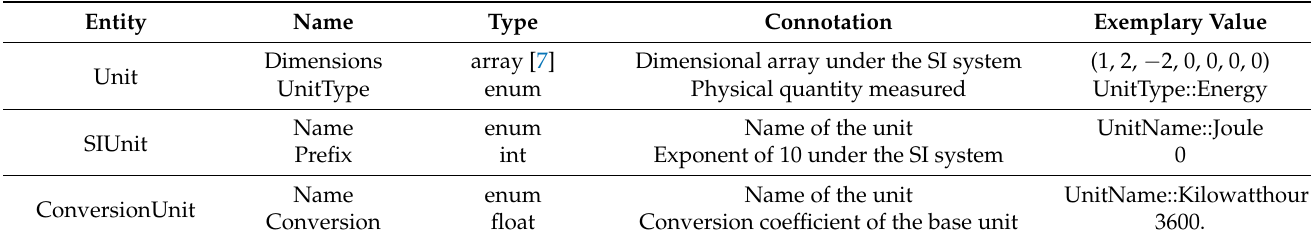
Table 2. Connotation of attributes in the unit system with example.